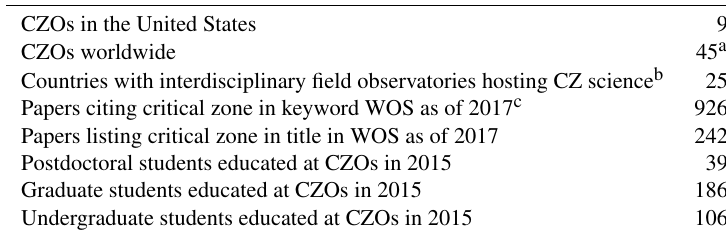
Table 1. Metrics enumerating the US CZO experiment.